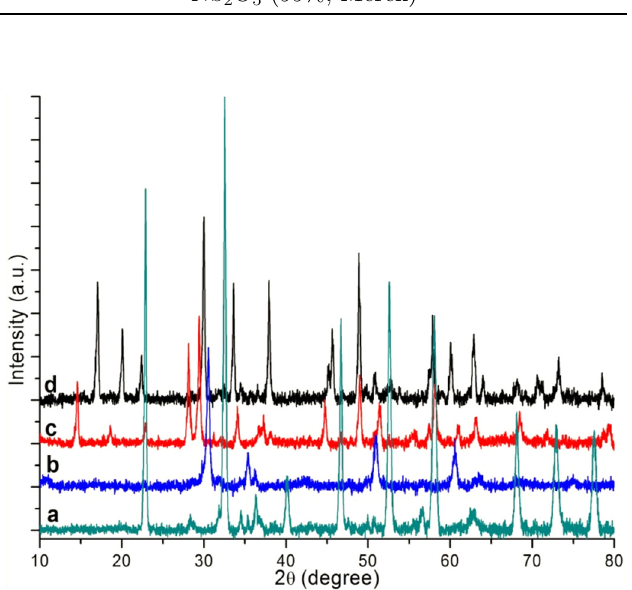
Fig. 1. The XRD patterns of: (a) ZnTa 2 O 6 , (b) ZnNb 2 O 6 , (c) MgTa 2 O 6 and (d) MgNb 2 O 6 materials prepared through the hydrothermal